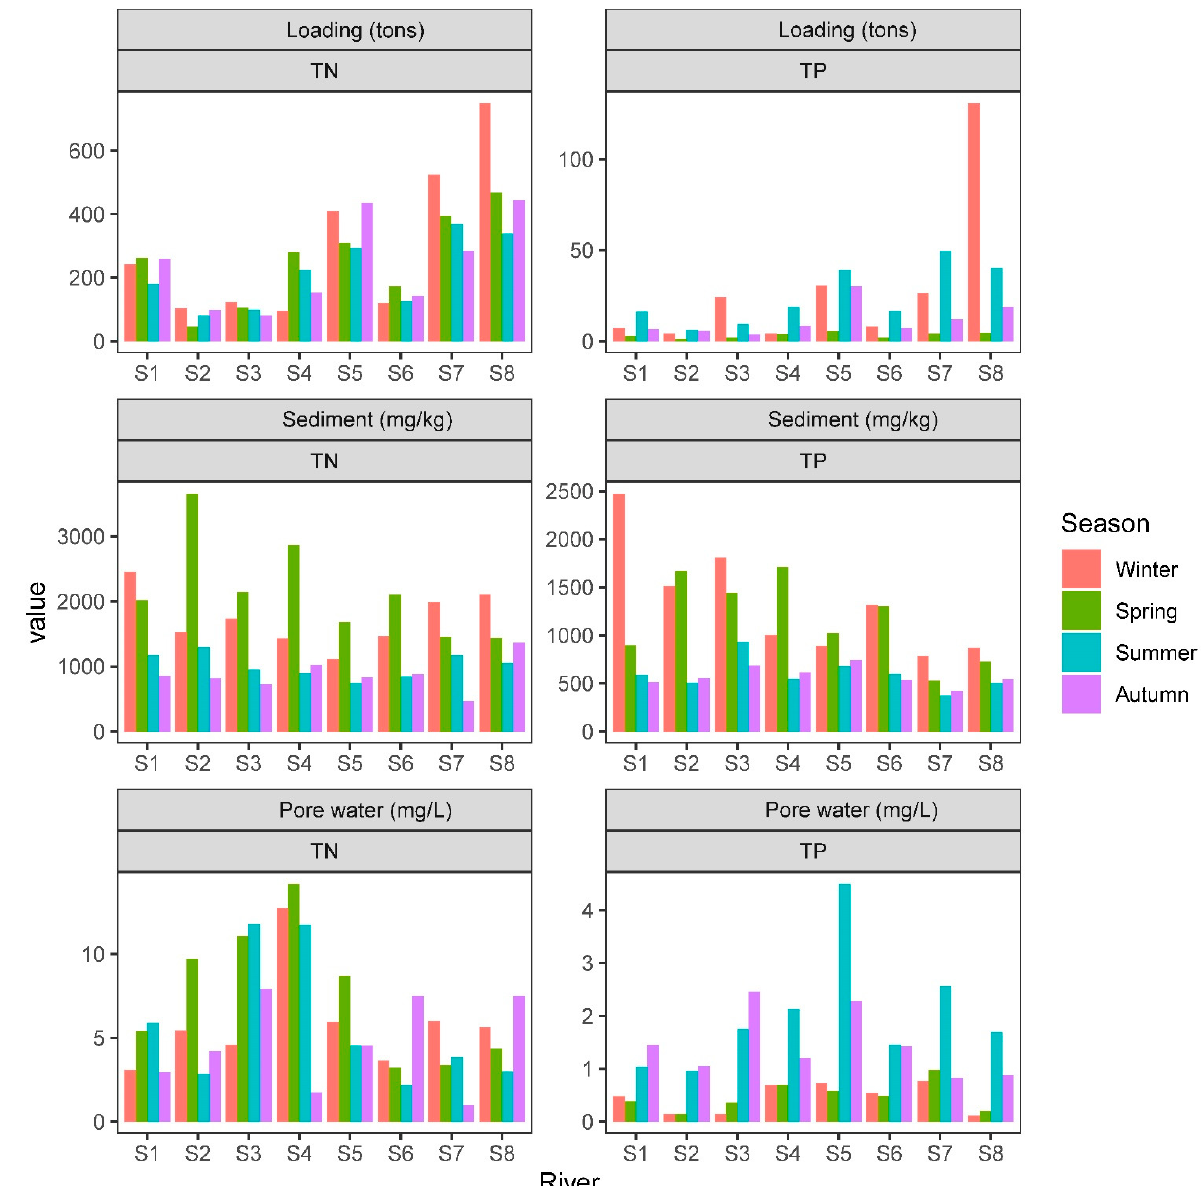
Figure 4. The seasonal variations of TN and TP loadings in each river for the first row; the seasonal concentrations of TN and TP in the river sediment and in the pore water for the middle and last row, respectively, including eight connected rivers flowing into Lake Yangcheng. Units located above each panel.